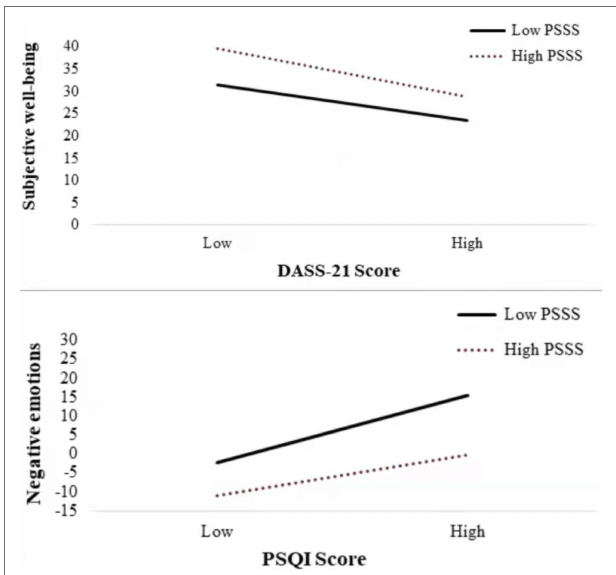
FIGURE 2 | Moderation of perceived social support to sleep quality and negative emotions and moderation of perceived social support to negative emotions and subjective